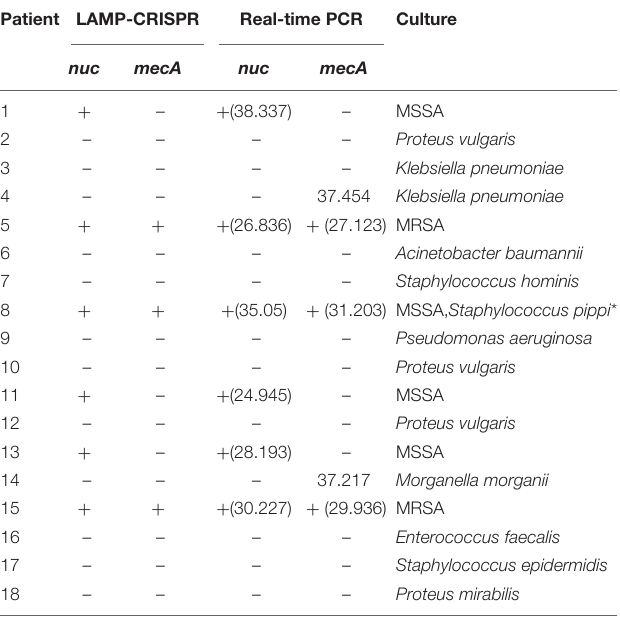
TABLE 2 | Results of 18 samples from DFI patients using the LAMP-CRISPR assay, real-time PCR, and the reference culture. Patient LAMP-CRISPR